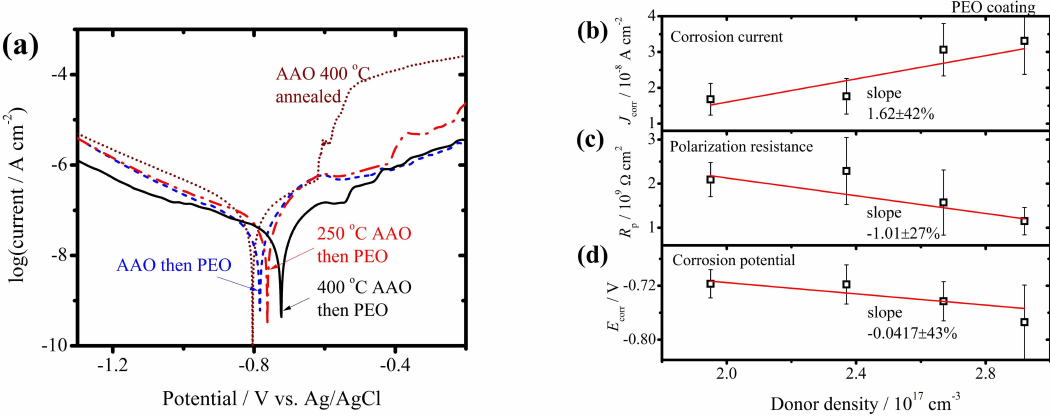
Figure 8. Influences of the AAO layer on anticorrosion of following PEO coating. Comparison of potentiodynamic polarization curves at scan rate 5 mV · s − 1 shows ( a ) the influences of annealing temperature on anticorrosion of its PEO coating. Correlation between donor density and ( b ) corrosion current, ( c ) polarization resistance, ( d ) corrosion potential of the PEO